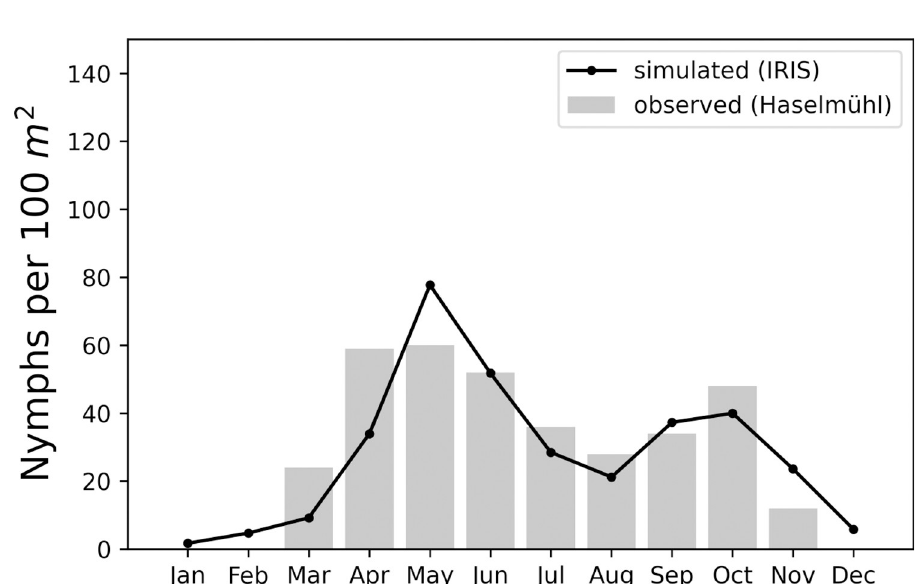
Fig 3. Result of the model calibration for the year 2013. The grey bars show the monthly observed nymphal densities (nymphs / 100 m 2 ) at the sampling site in Haselmu¨hl. The black connected dots show the monthly simulated nymphal densities with calibrated parameter values. The root-mean-square error (RMSE) is